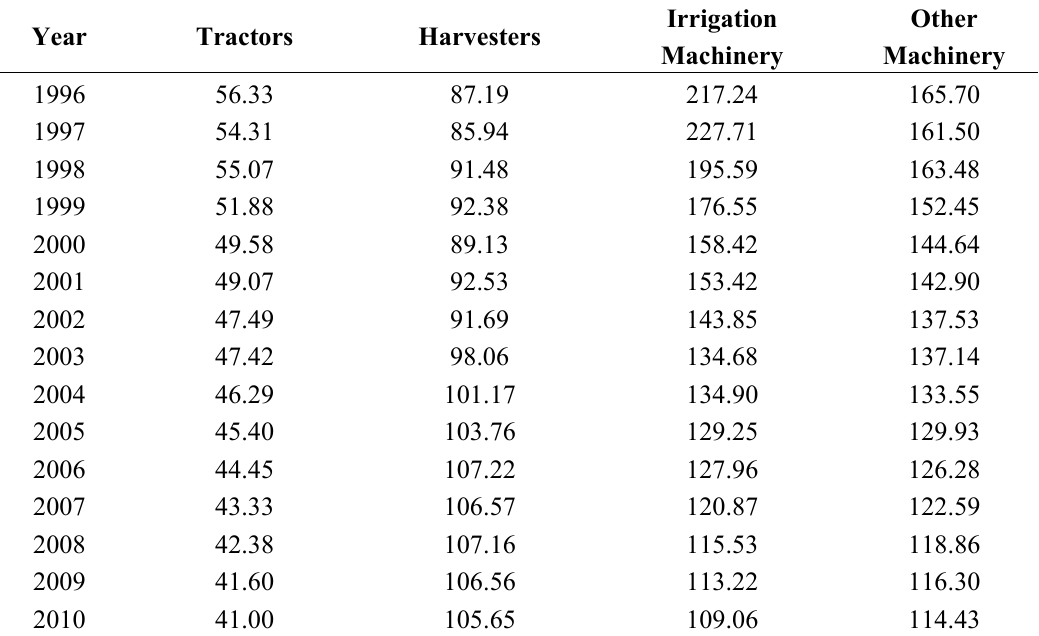
Table 4. Average annual working hours (h) of agricultural machinery.